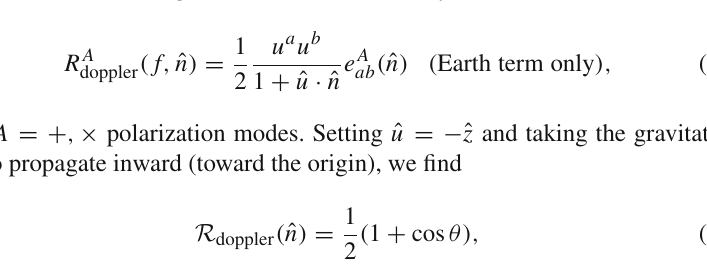
Fig. 26 Antenna pattern for unpolarized gravitational waves for a one-way tracking Doppler frequency measurement with ˆ u = −ˆ z . The gravitational waves propagate toward the origin. The 3-d antenna pattern is axially symmetric around ˆ